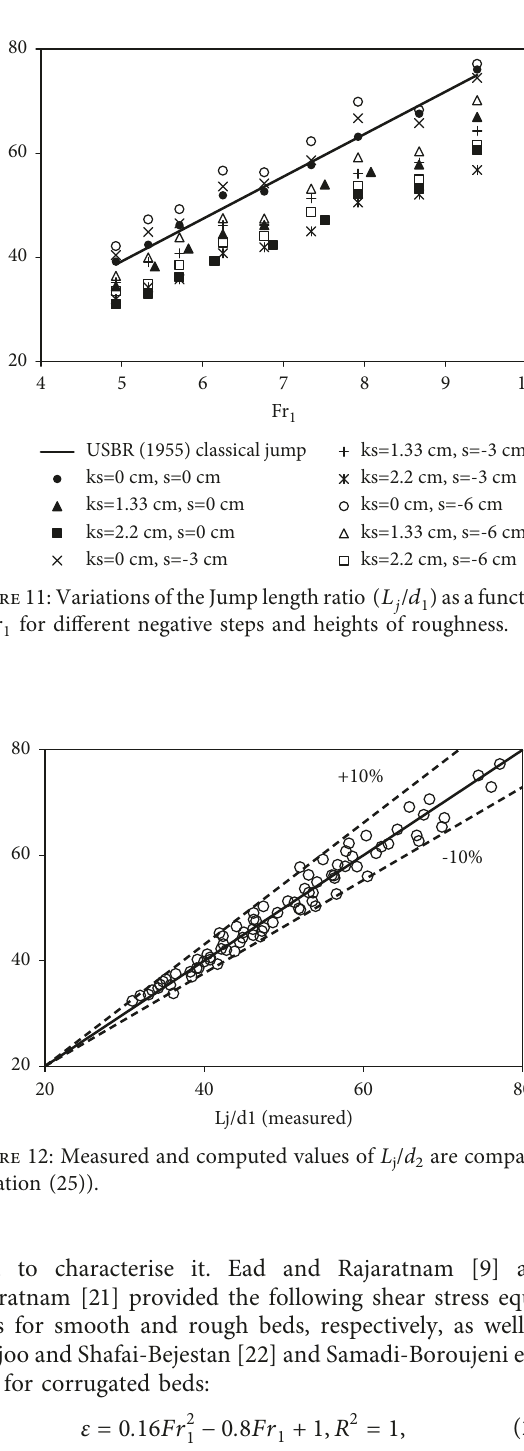
j / d 2 are compared